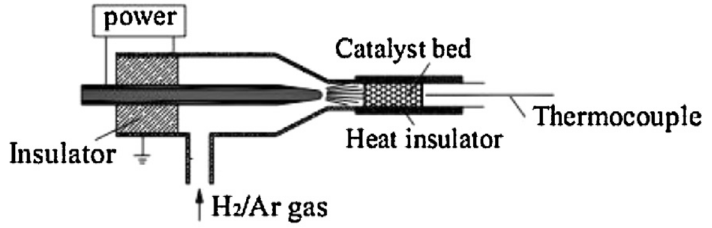
Figure 3. The schematic of catalyst reduction process by atmospheric cold plasma jet. Reproduced from [68] with permission of Elsevier. Copyright